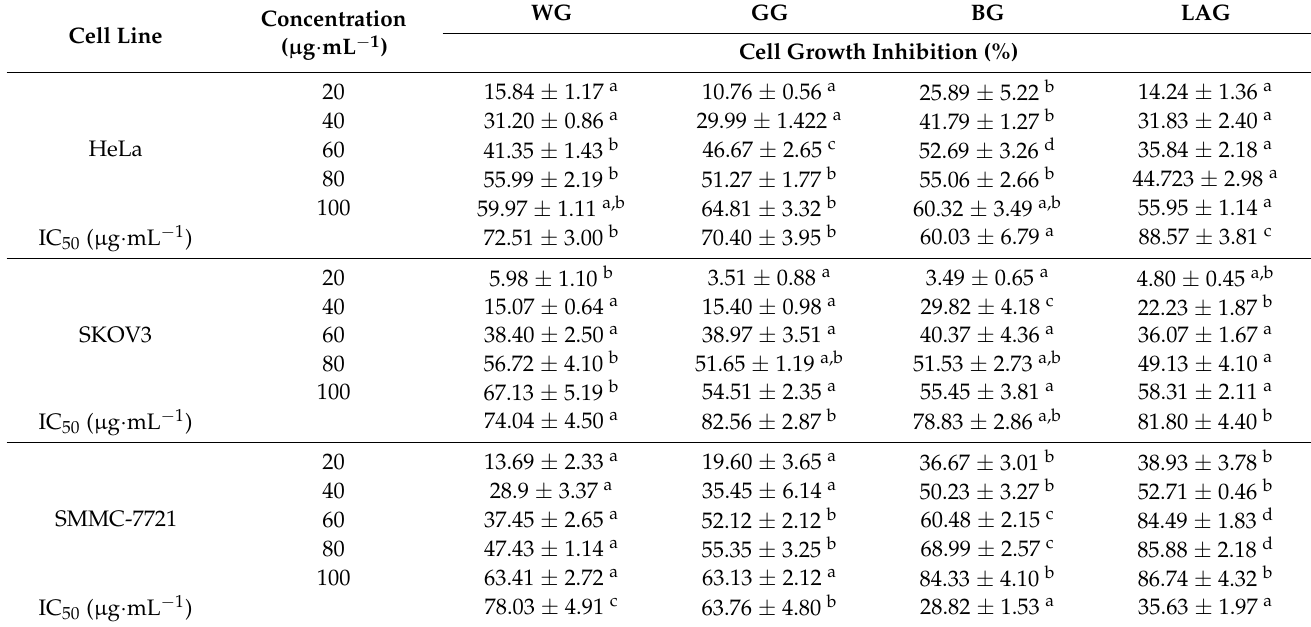
Table 3. The inhibition rate of WG, GG, BG and LAG on HeLa cell; SKOV3 cell; and SMMC-7721